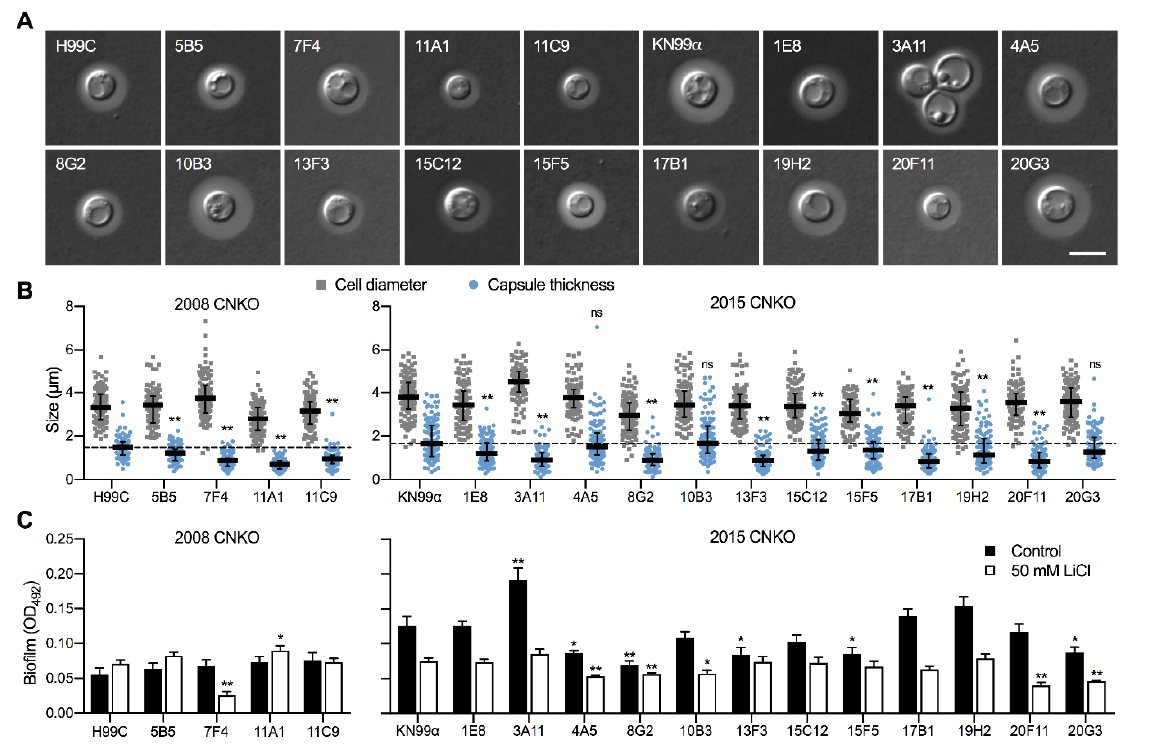
FIGURE 6: The ubiquitin/proteasome system contributes to capsule and biofilm formation. (A) DIC microscopy images of the indicated ubiq- uitin/proteasome-associated C. neoformans strains (see Table 1) grown in CIM for 48 h and stained with India ink to visualize capsule via dye exclusion. H99C, Wt control for strains from the 2008 CNKO collection. KN99 a , Wt control for strains from the 2015 CNKO collection. Scale bar, 5 µm. (B) Quantification of cell diameter (grey squares) and capsule thickness (blue circles) for cells from panel A. The experiment was performed twice, and at least 100 cells were analyzed per strain and condition. The black bar indicates the median – interquartile range. The dotted black lines indicate the median capsule sizes of the respective Wt controls. ns, not significant. ** P < 0.01 by two-way ANOVA compared to the respective Wt. (C) Biofilm formation by ubiquitin/proteasome-associated mutants. Indicated strains were grown under biofilm-inducing conditions without (control) or with 50 mM LiCl and quantified by the XTT reduction assay. OD 492 , optical density at 492 nm. Results are the mean – SEM of three independent experiments, each performed in triplicate. * P < 0.05, and ** P < 0.01 by t -test compared to the respective Wt growth